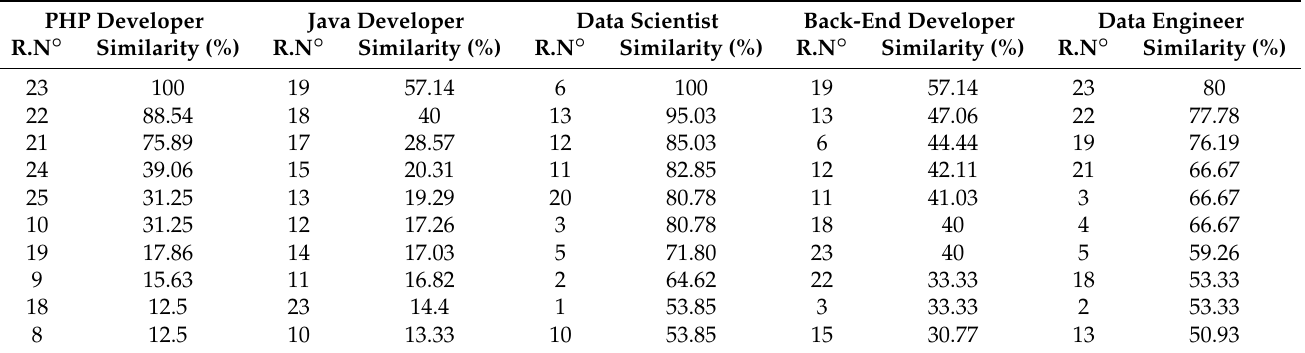
Table 5. Finding the top-10 most matching resumes for PHP Developer, Java Developer, Data Scientist, Back-end Developer, and Data Engineer profiles.